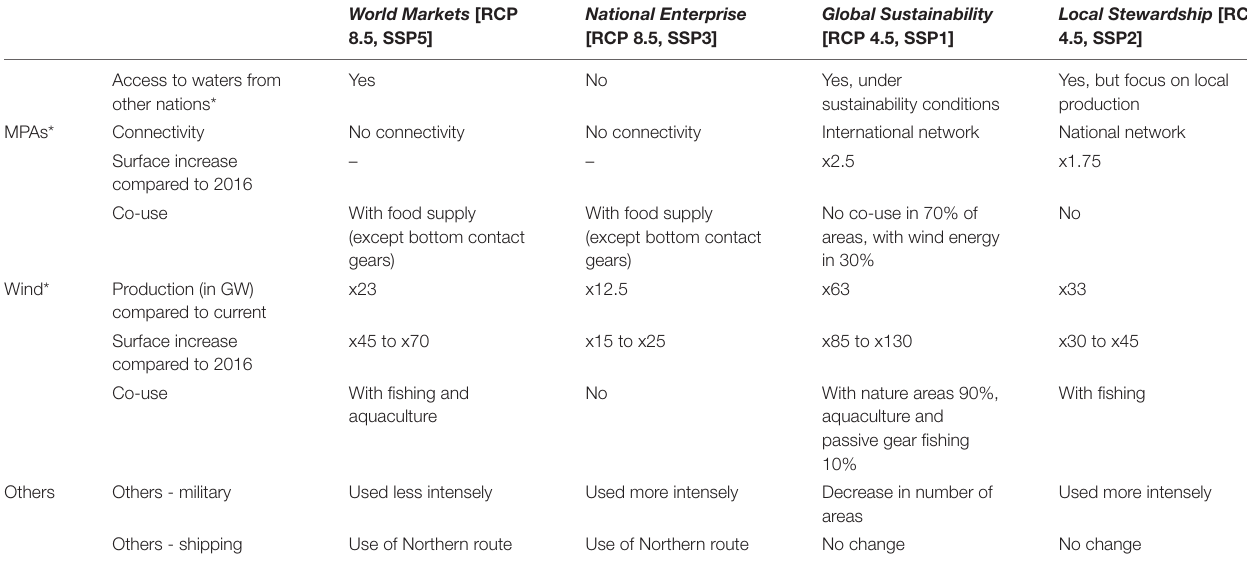
TABLE 2 | Marine spatial planning situation in 2050 in Europe for the different scenarios based on Matthijsen et al. (2018), to be adapted to regional